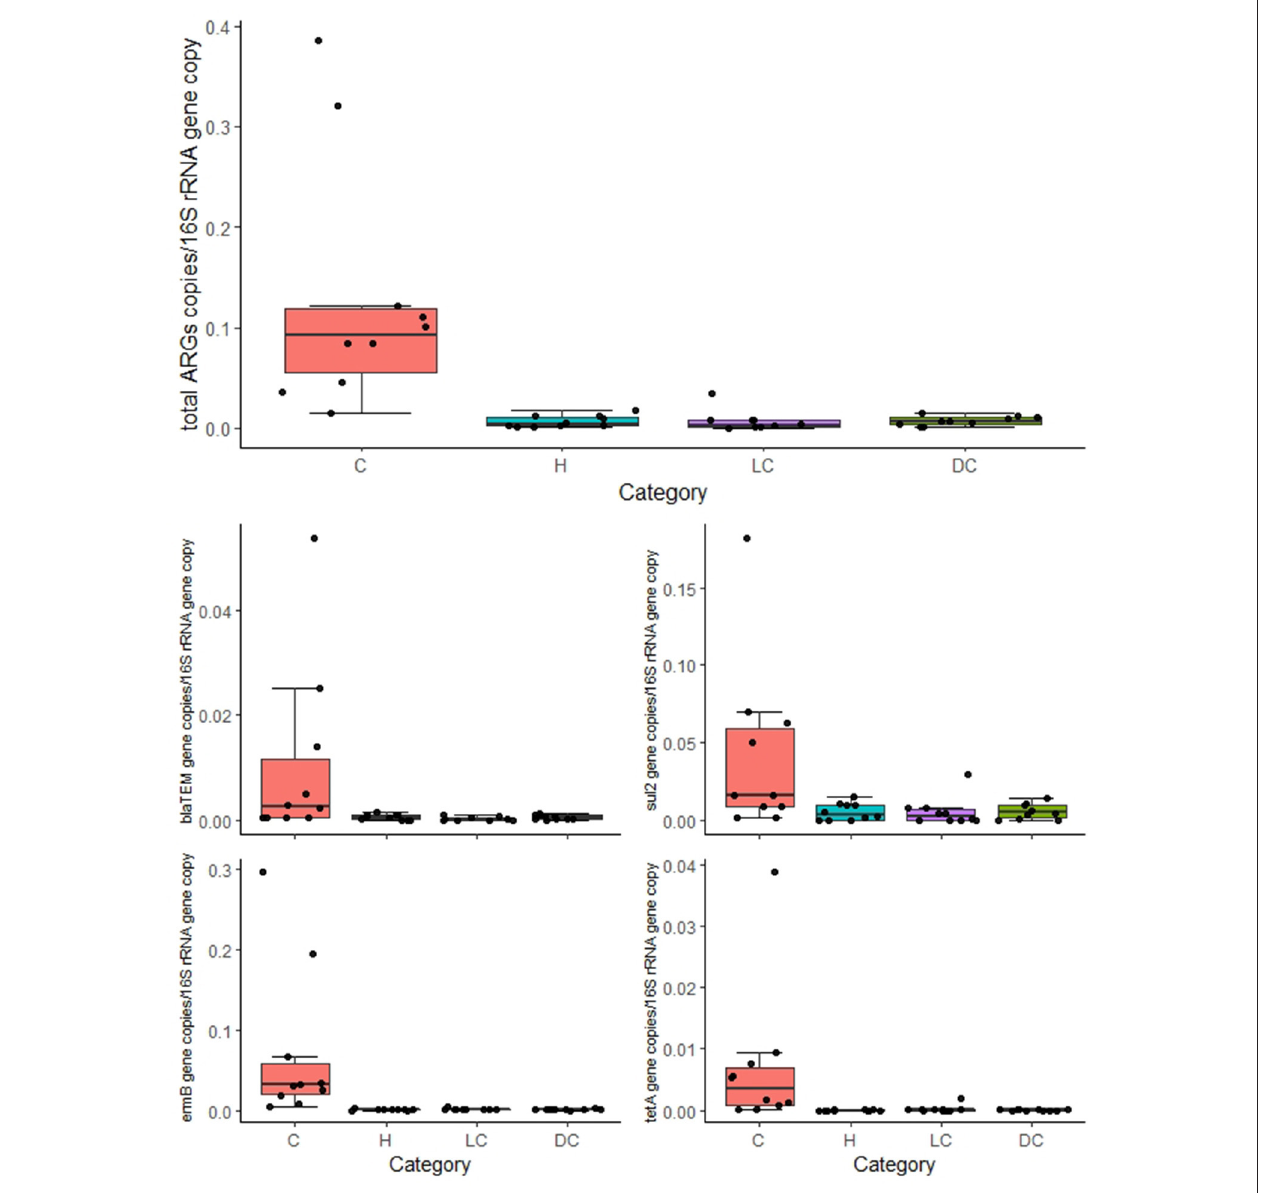
FIGURE 1 | Normalized abundances of genes according to animal category. Boxplots of the distribution of abundances of total antibiotic resistance genes (ARGs), bla TEM , erm B, sul 2, and tet A within bacterial communities in calves (C), heifers (H), lactating cows (LC), and dry cows (DC). The thick horizontal line represents the median, the box represents 50% of the values, the whiskers extend to the highest and lowest value within the 1.5 interquartile range (IQR), and the dots represent the single